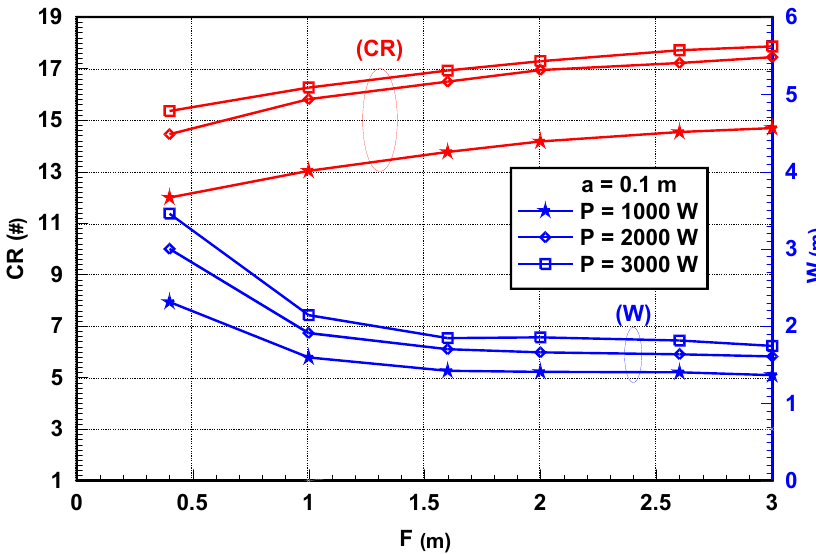
Figure 24. Concentration ratio and the width of a CPVT collector plotted against the focus distance with different power required.